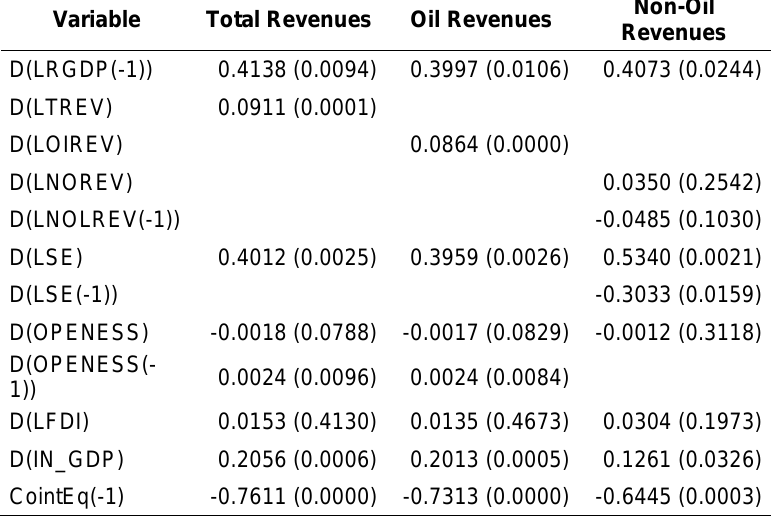
Table 6. Autoregressive Distribution Lag (ADRL) Cointegrating Model Results. Dependent Variable: Real Gross Domestic Product